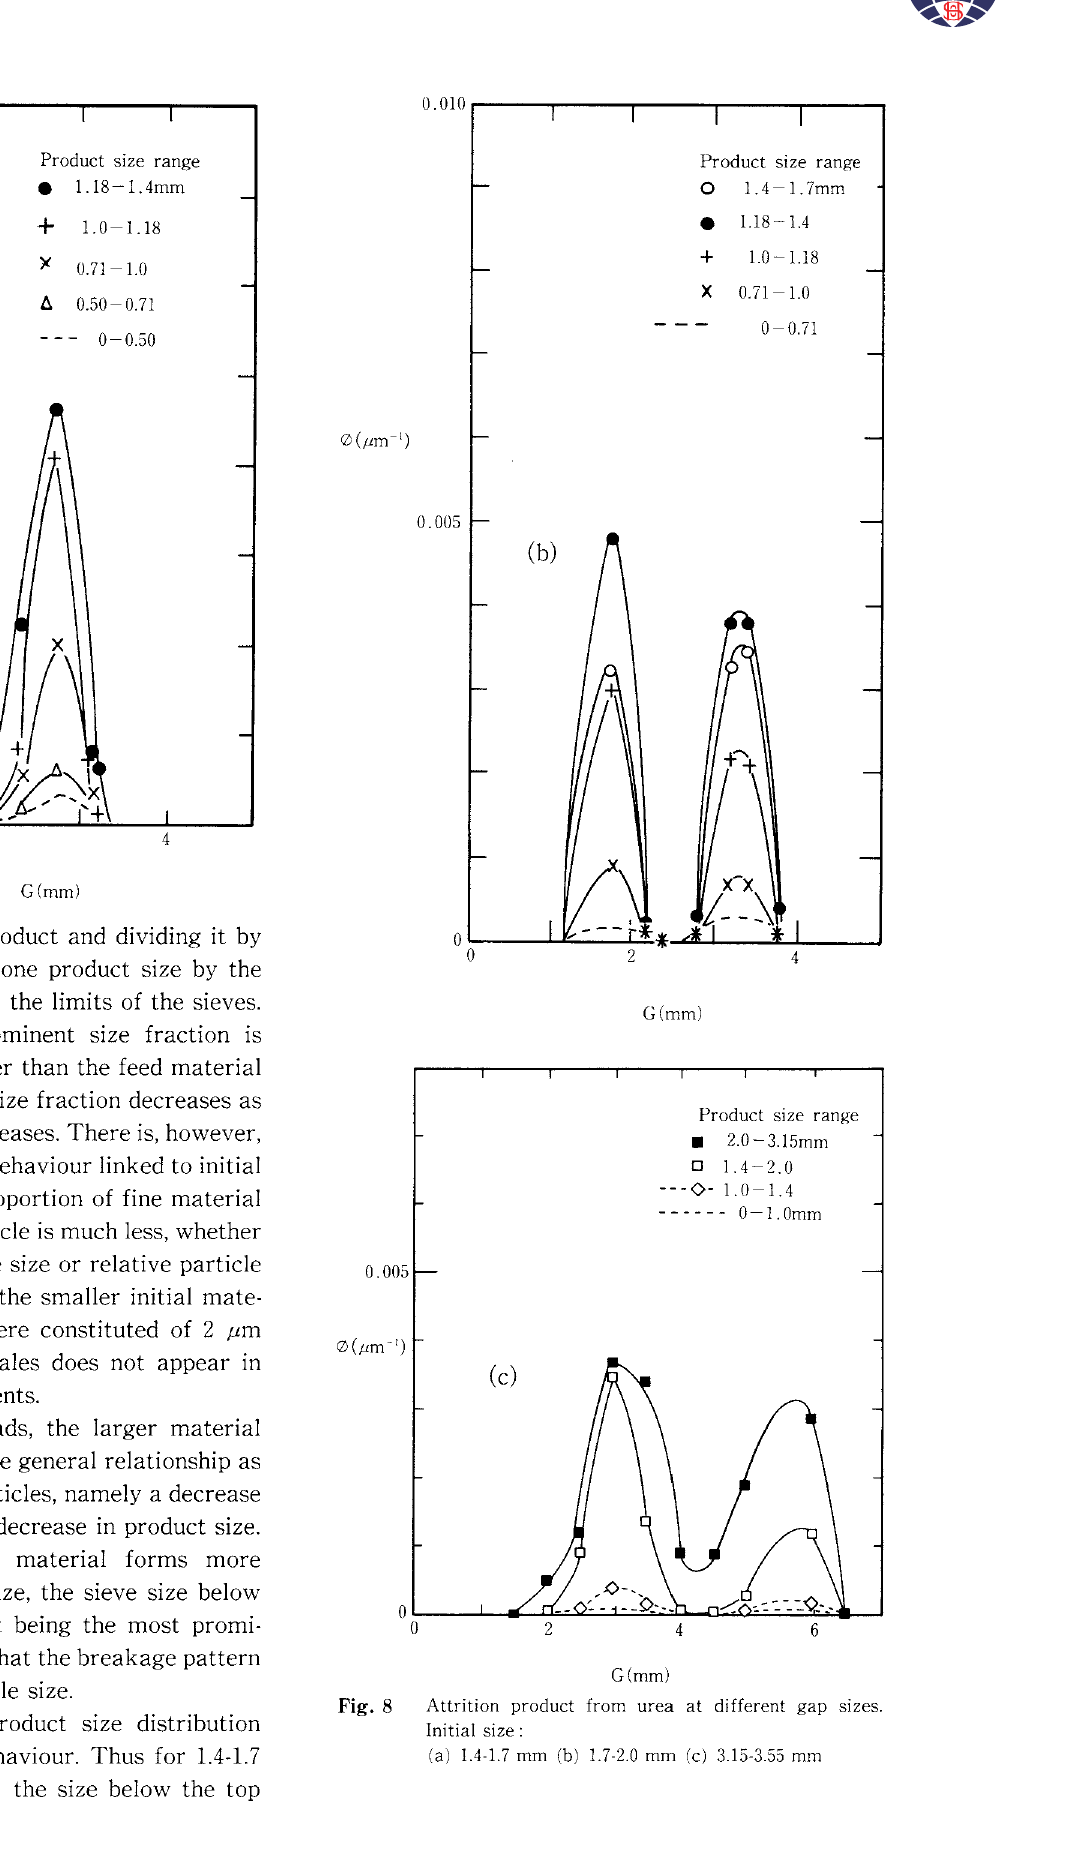
Fig. 8 Attrition product from urea at different gap